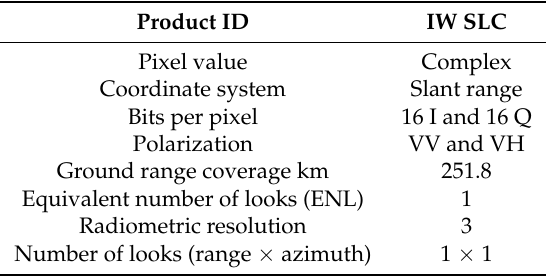
Table 3. General properties that apply to all